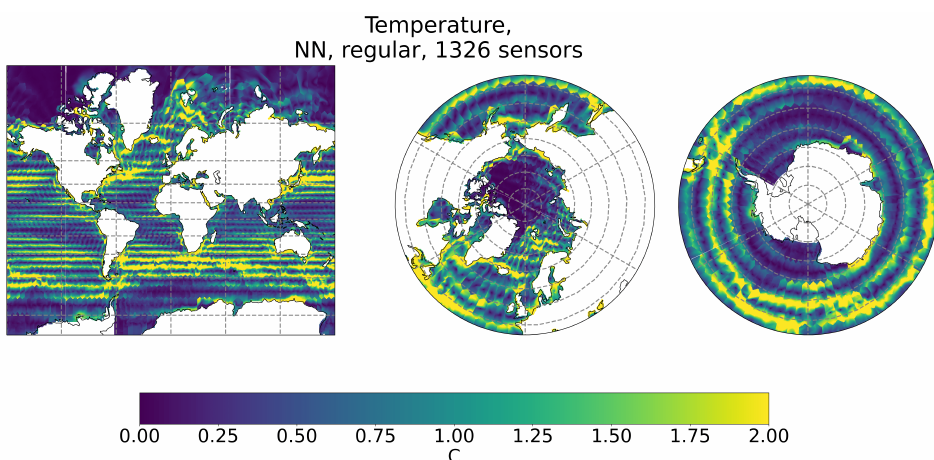
Figure A8. Spatial distribution of reconstruction bias by the Nearest Neighbor (NN) method from 1326 measurements with regular placement.